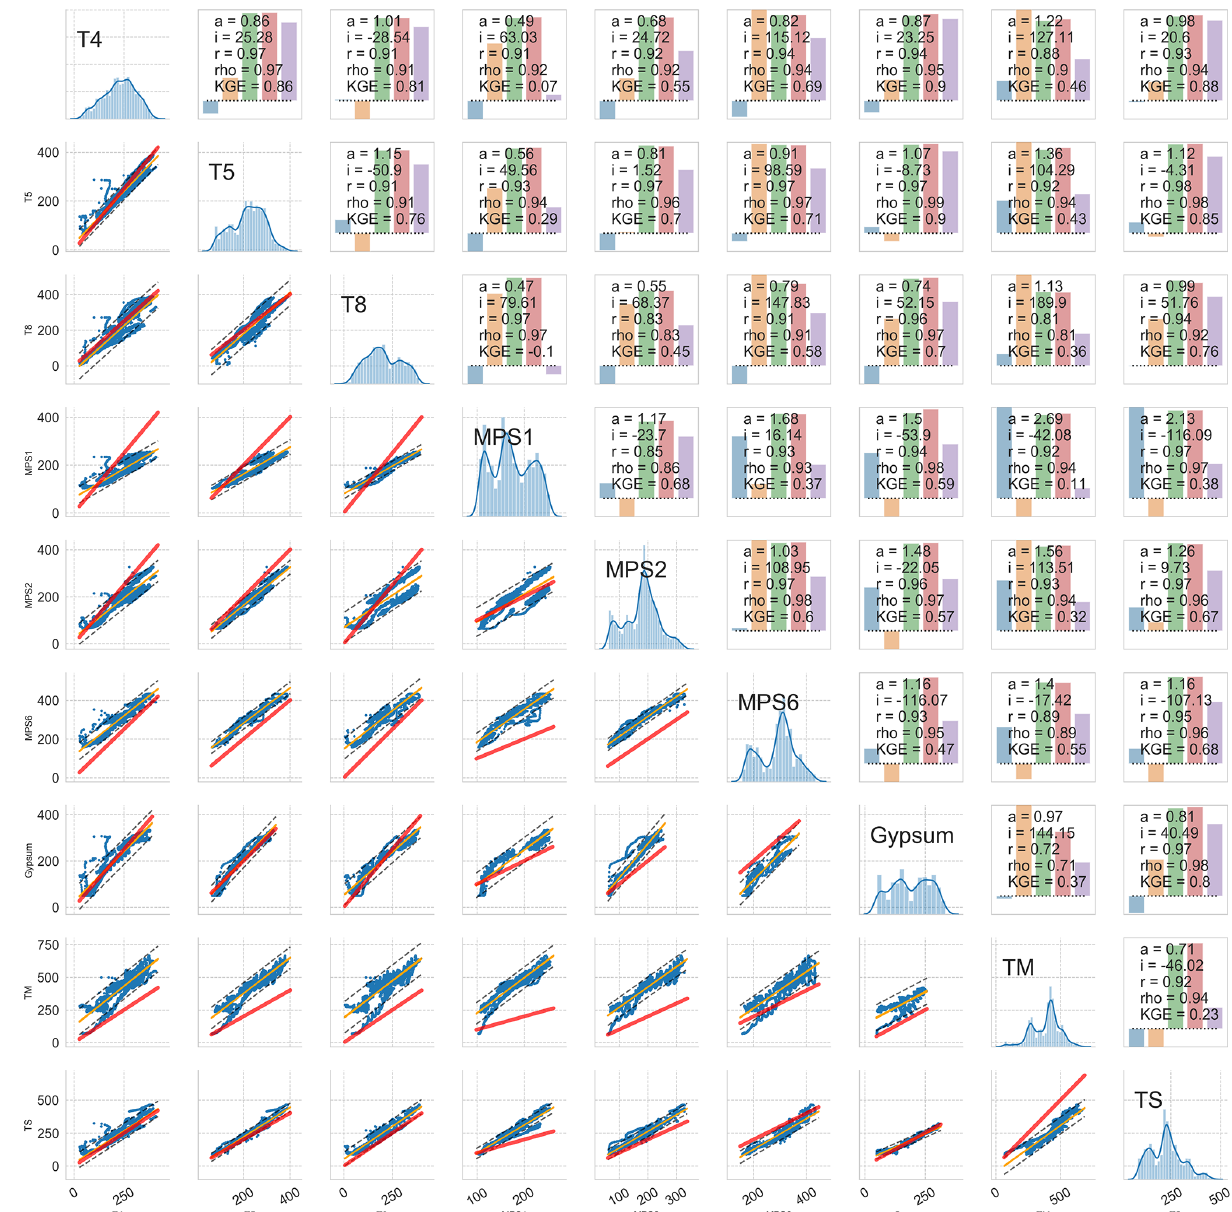
Figure 7. Correlation matrix of all plausible sensor systems for matric potential (given in hPa). Diagonal panels give histogram and kernel density distribution of 0.5h means of all sensors of one system. Lower half gives scatter plot (blue dots), linear regression (orange line), 0.95 predictive uncertainty bands (grey dashed lines) and the 1 : 1 line (red). The upper half reports the respective correlation measures, with a and i as scaling factor and intercept of the linear regression model, r as Pearson correlation coefficient, rho as Spearman rank correlation coefficient, and KGE as Kling–Gupta efficiency. These values are plotted as bars in the same order in the background, where a is plotted as deviation from unity and i is scaled with